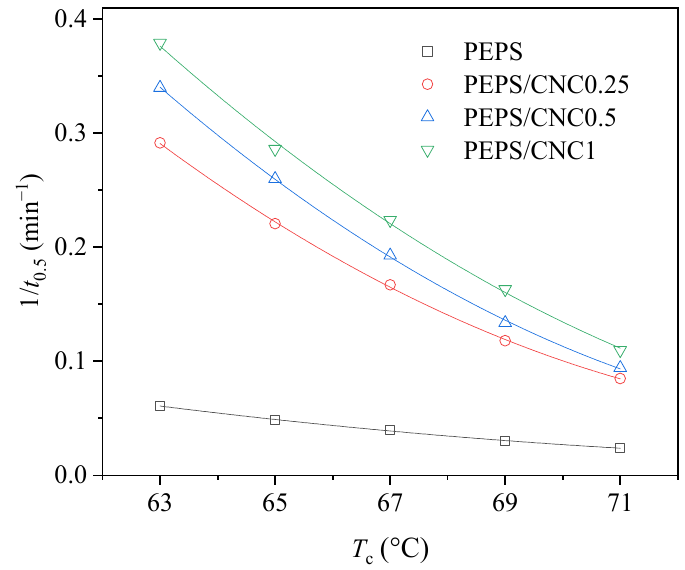
Figure 5. Variation of 1/ t 0.5 with T c for PEPS and PEPS/CNC composites.